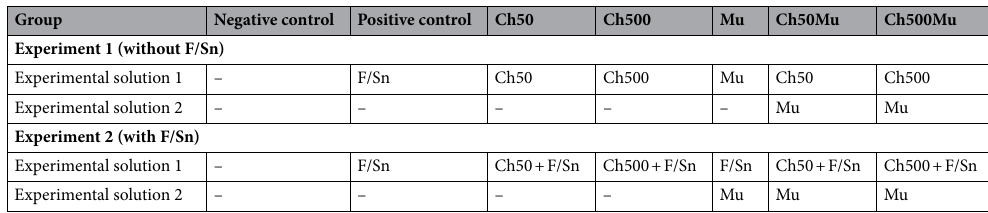
Table 2. Experimental solutions used in the respective group and experiment. F/Sn 500 ppm F − and 800